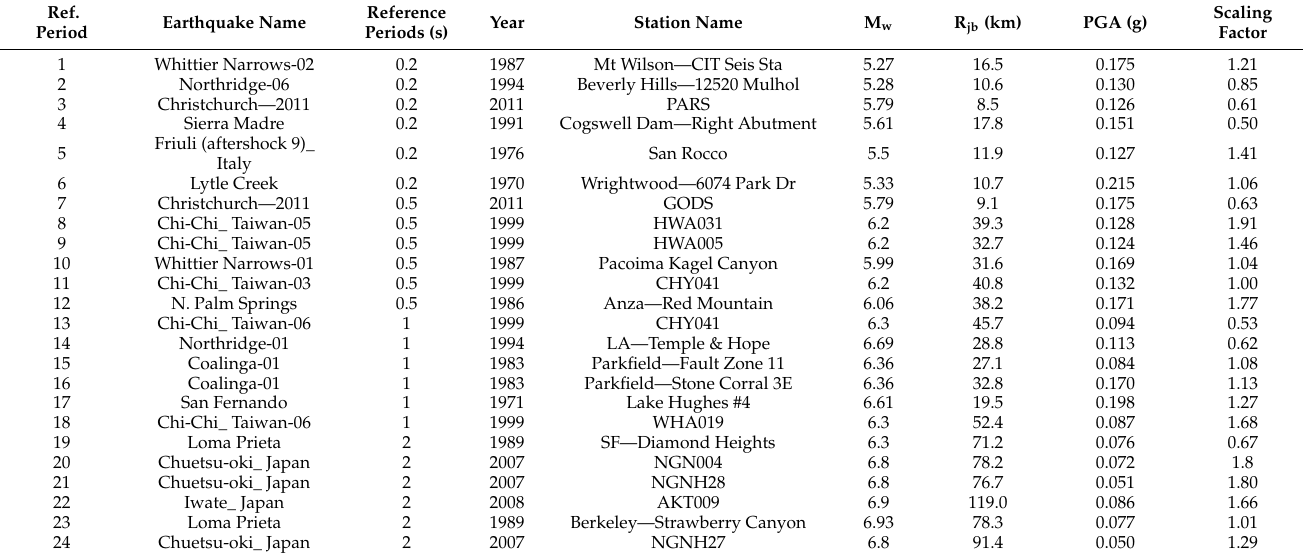
Figure 4. Acceleration response spectrum (RSA) as stipulated in AS 1170.4-2007 [1] for: ( a ) B e site compared to bedrock response spectra (based on the Table 1 ground motions), and ( b ) D e site compared to site-specific mean response spectra generated from this study. Table 1. Detail of the 24 earthquake records selected from the PEER database.